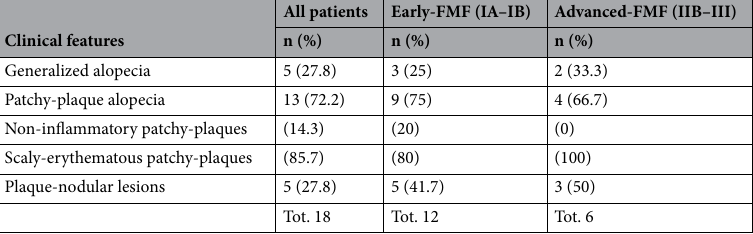
Table 2. Different alopecia patterns on a clinical point of view.